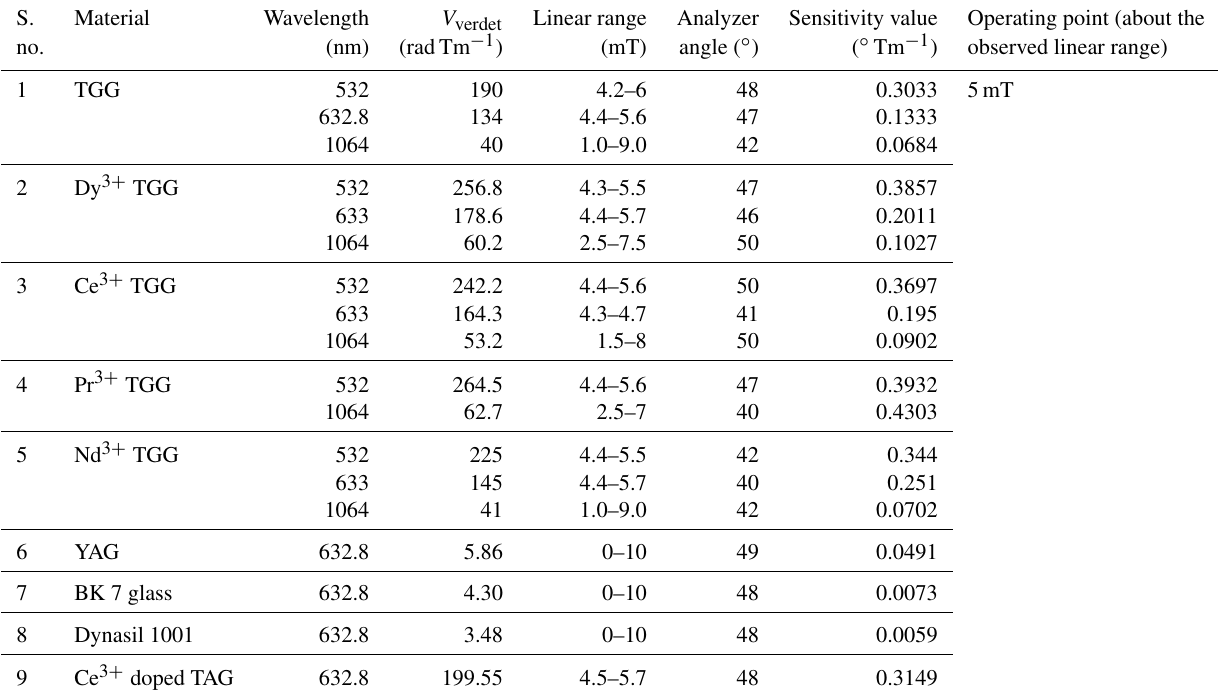
Table 7. Analyzing linear regions of various MO materials over a magnetic field range of 0–10mT. S. Material Wavelength V verdet Linear range Analyzer Sensitivity value Operating point (about the